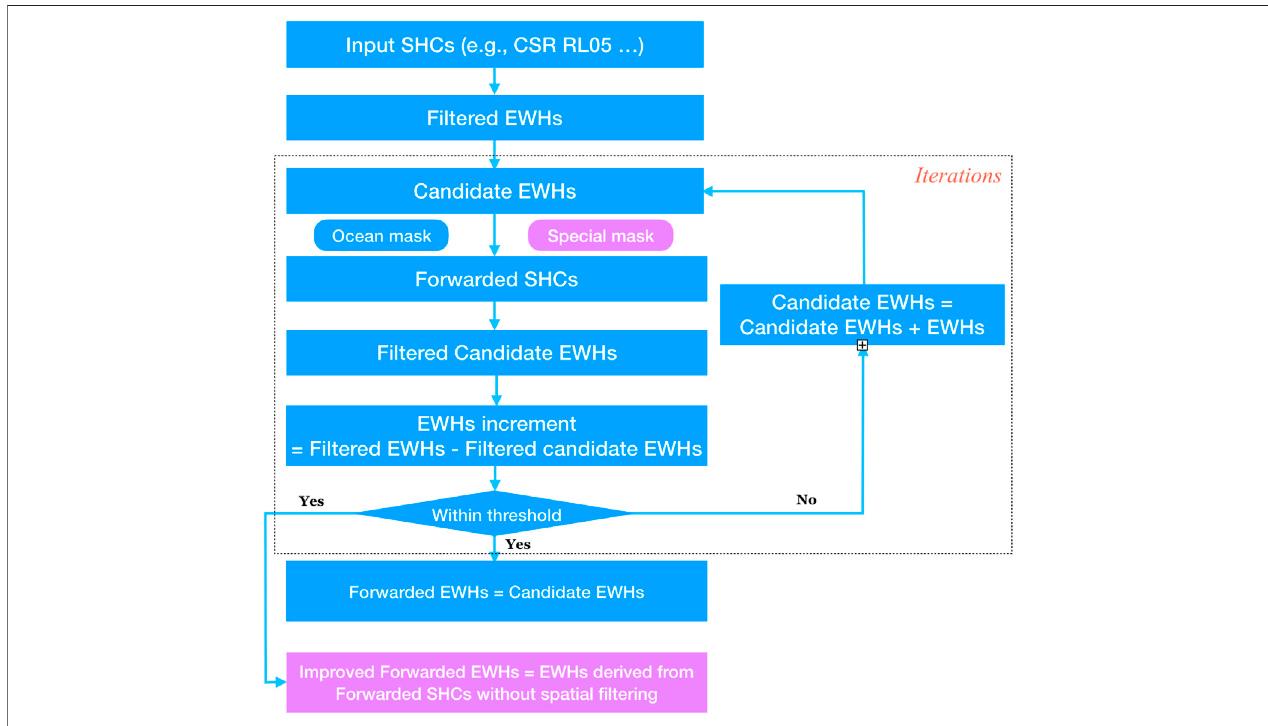
FIGURE 2 | The fl owchart of forward-modeling method. The pink text boxes relate to the improved forward modeling method.